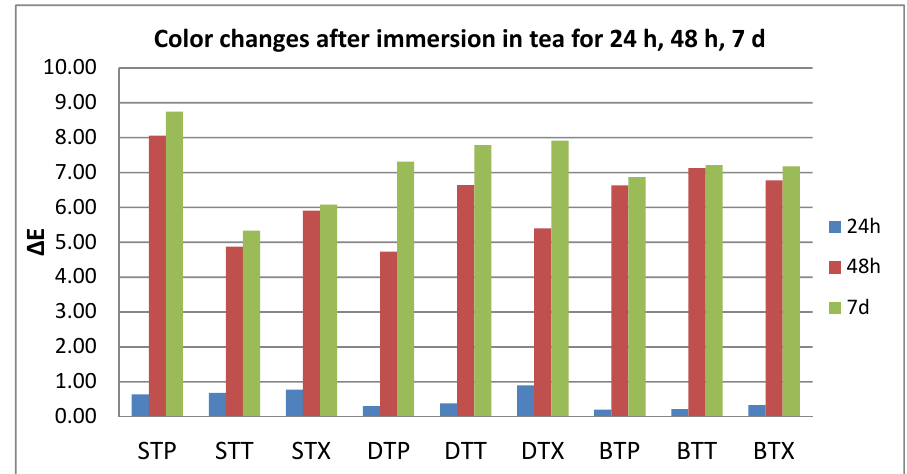
Figure 2. Mean values for ∆ E parameter for all the tested values after immersion in coffee.